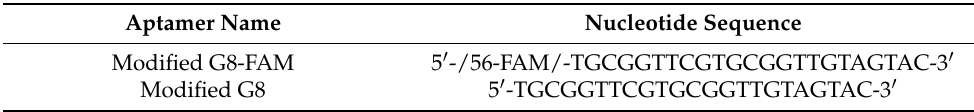
Table 1. The nucleotide sequences of the modified